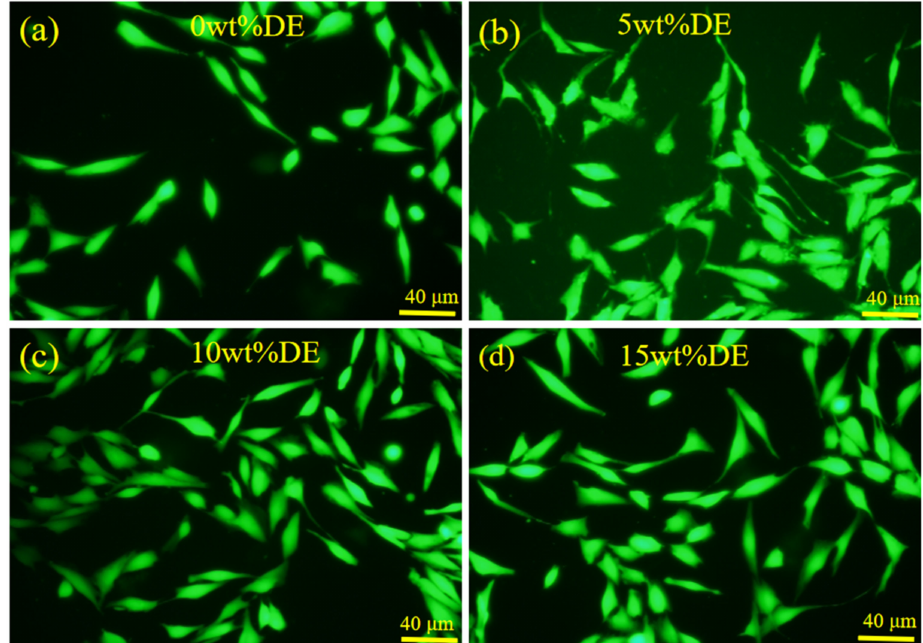
Figure 6. Fluorescent images of MG63 cell on coatings with different contents of DE at 3 d, ( a ) 0wt%; ( b ) 5wt%; ( c ) 10wt%; ( d )